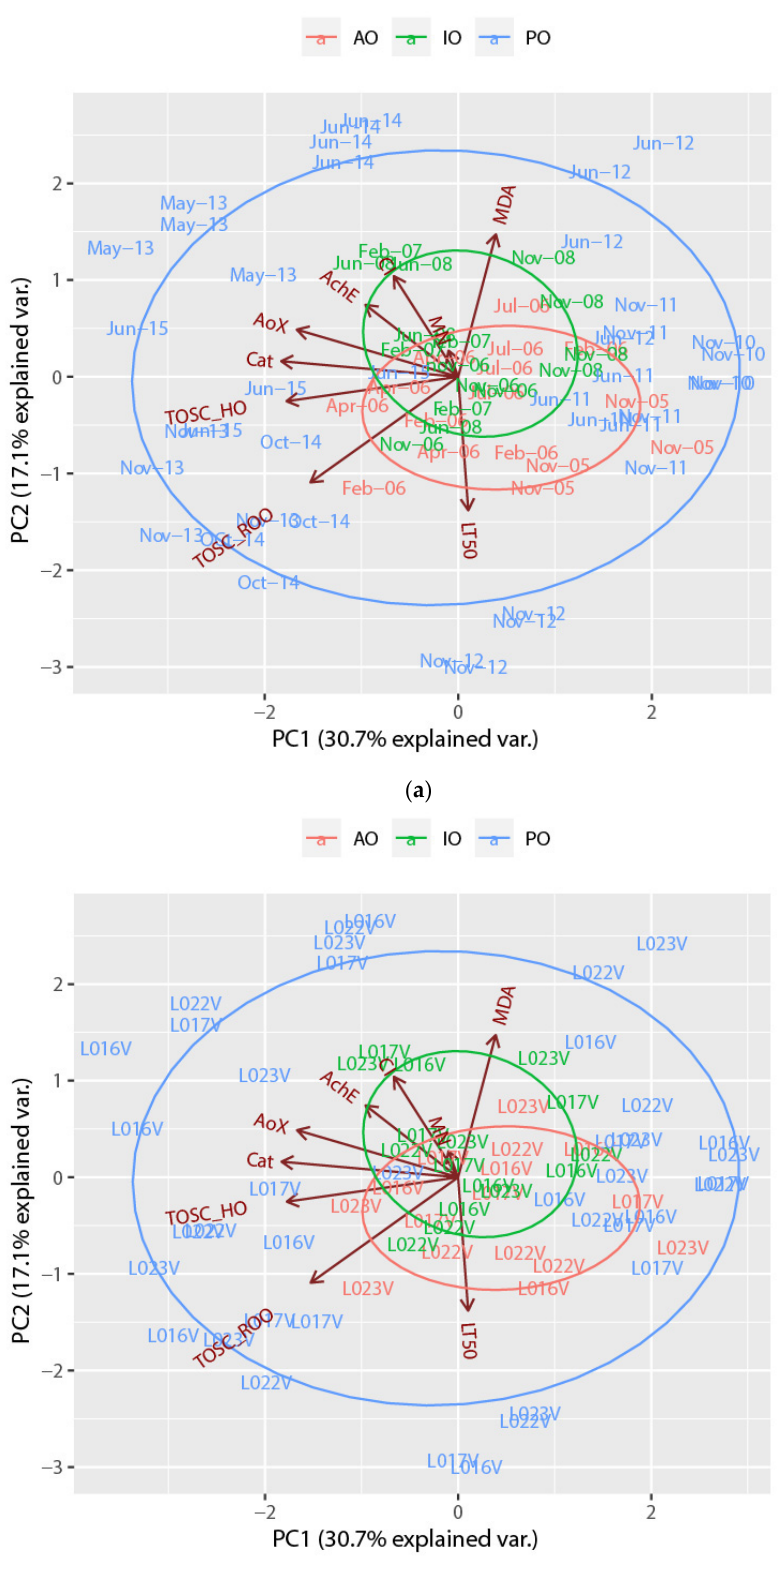
Figure 3. Biplots of the Manila clam ( R. philippinarum ) samples and the loadings of biomarkers and biological indices, labelled as ( a ) surveys and ( b ) sites, on the first two principal components. (AO = ante operam , IO = in opera , PO = post operam ).